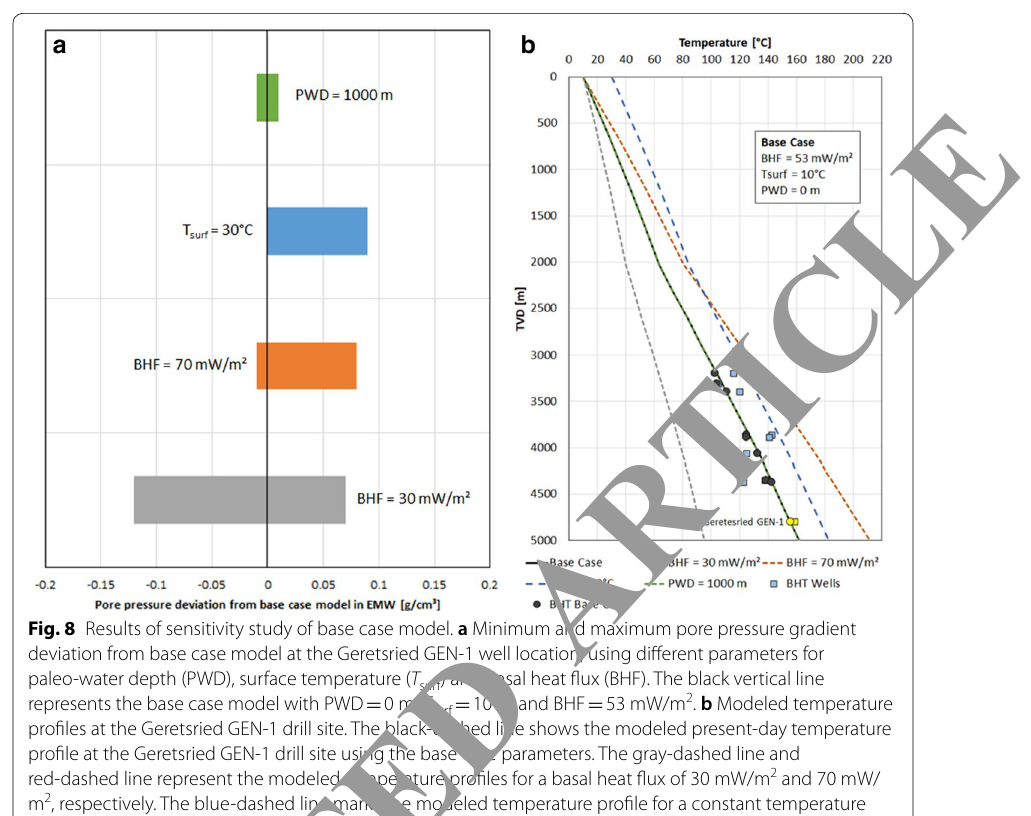
Fig. 8 Results of sensitivity study of base case model. a Minimum and maximum pore pressure gradient deviation from base case model at the Geretsried GEN-1 well location, using different parameters for paleo-water depth (PWD), surface temperature ( T surf ) and basal heat flux (BHF). The black vertical line represents the base case model with PWD 0 m, T surf 10 °C and BHF 53 mW/m 2 . b Modeled temperature = = = profiles at the Geretsried GEN-1 drill site. The black-dashed line shows the modeled present-day temperature profile at the Geretsried GEN-1 drill site using the base case parameters. The gray-dashed line and red-dashed line represent the modeled temperature profiles for a basal heat flux of 30 mW/m 2 and 70 mW/ m 2 , respectively. The blue-dashed line marks the modeled temperature profile for a constant temperature profile of 30 °C and the green-dashed line overlying the base case line shows that a change in paleo-water depth to 1000 m has no impact on the modeled temperature profile. The squares represent the measured bottom-hole temperatures in the AOI (light blue filling) and at the Geretsried GEN-1 drill site (yellow filling), while the dots represent the modeled bottom-hole temperatures in the AOI (black fillings) and at the Geretsried GEN-1 drill site (yellow